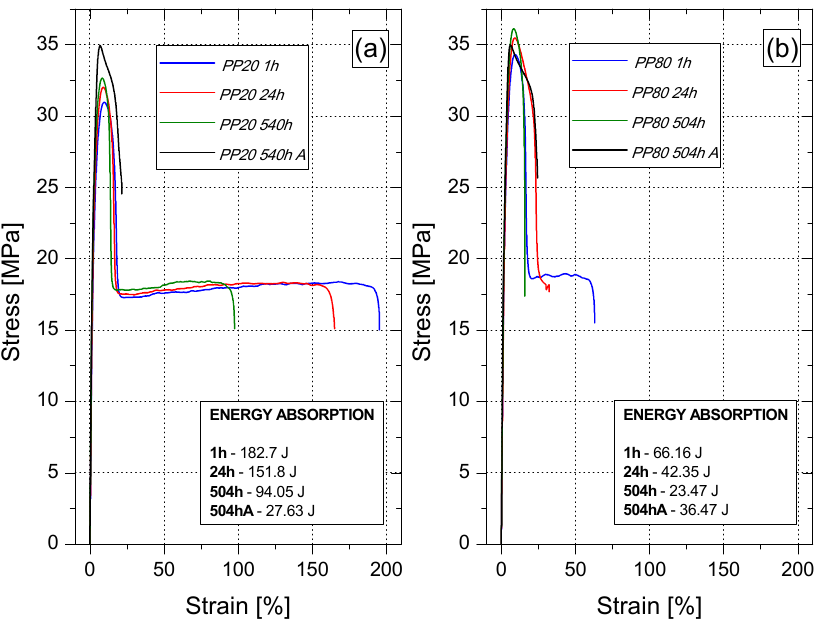
Figure 7. Selected stress-strain curves of conditioned and annealed PP samples; PP20 ( a ) and PP80 ( b ).